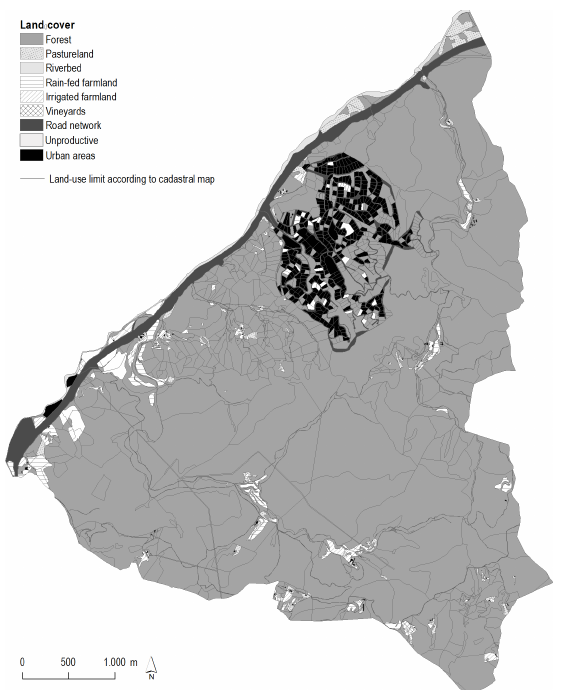
Fig. 5 . Land-cover map of Olzinelles (2010).